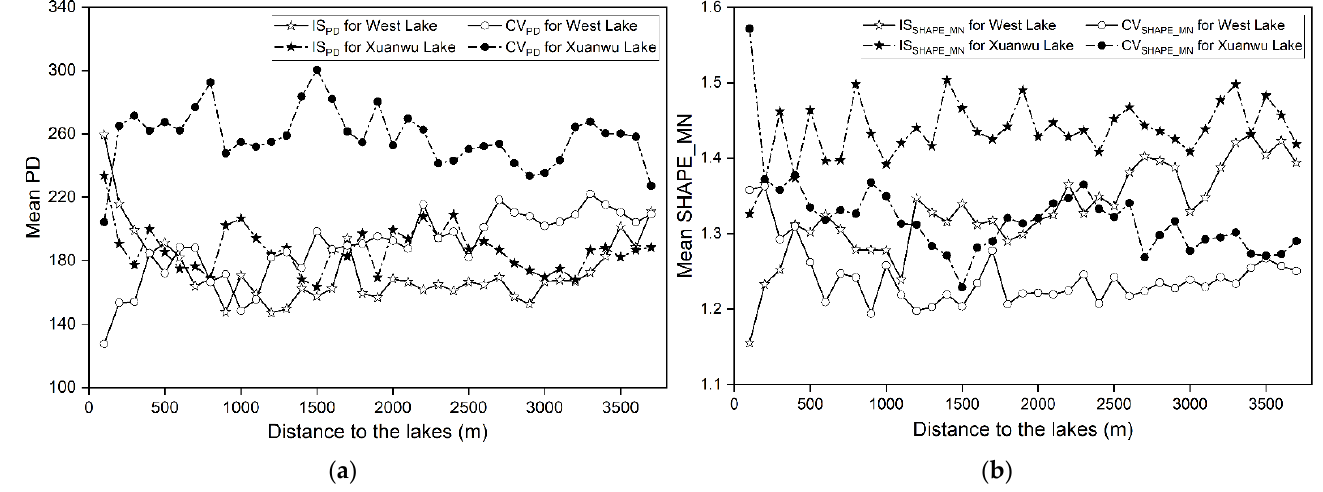
Figure 8. Mean ( a ) patch density (PD), and ( b ) SHAPE_MN at different distances to the lakes.